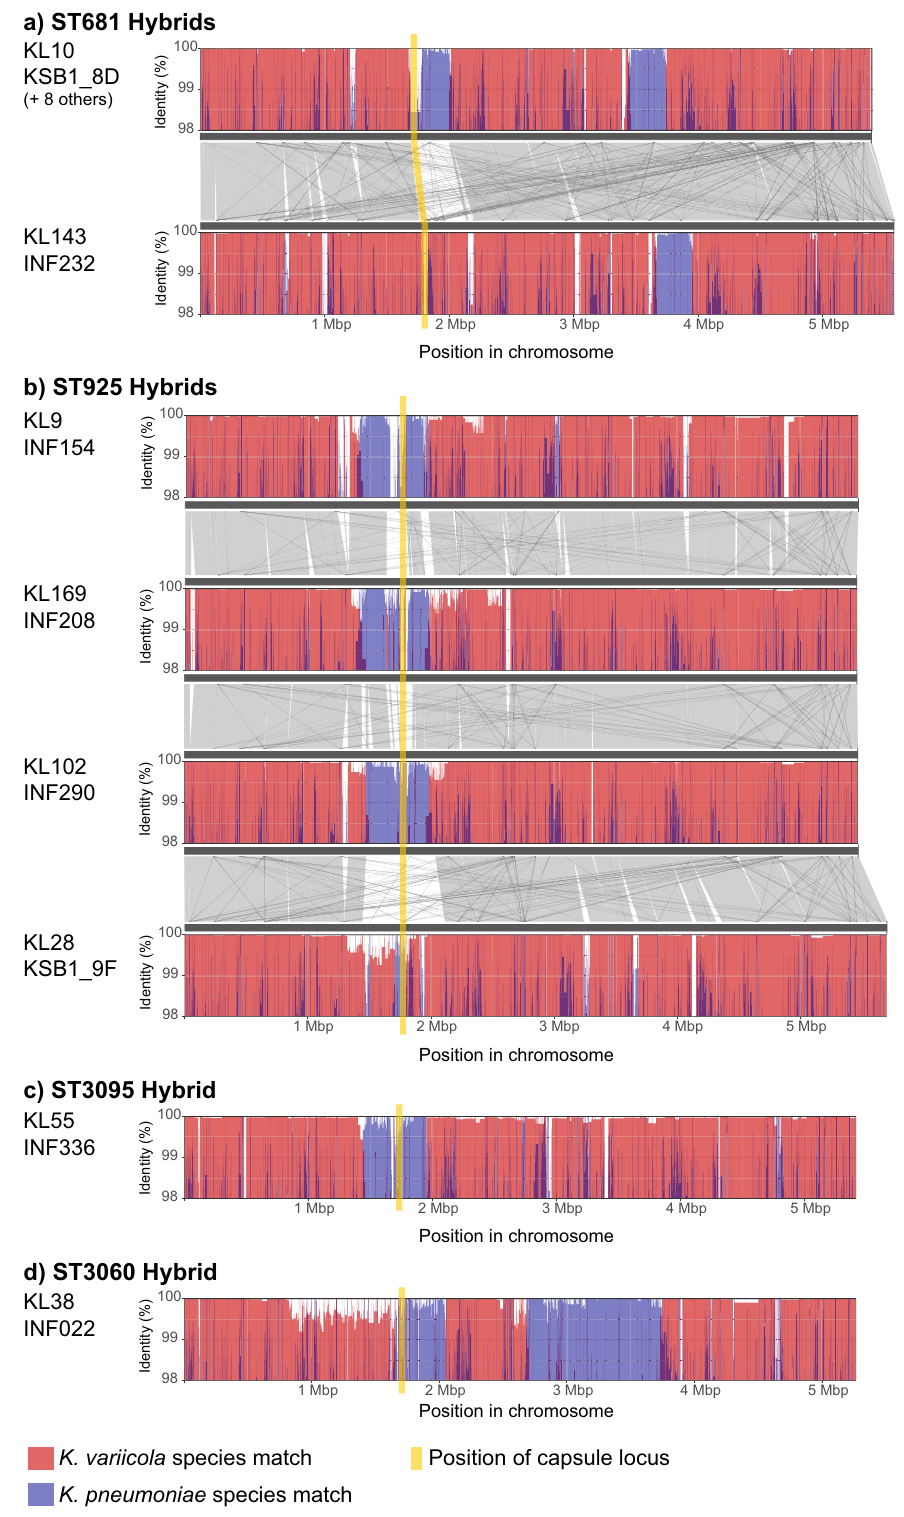
Fig. 5 Details of hybrids identi fi ed between different species of the Klebsiella pneumoniae species complex. Plots show nucleotide identity to K. variicola (red) or K. pneumoniae (blue) sequences in sliding windows along each genome. For a and b , homology between different genomes is shown in grey. Position of the capsule (K) biosynthesis locus is shown in yellow and is directly adjacent to the outer lipopolysaccharide (O) synthesis locus.